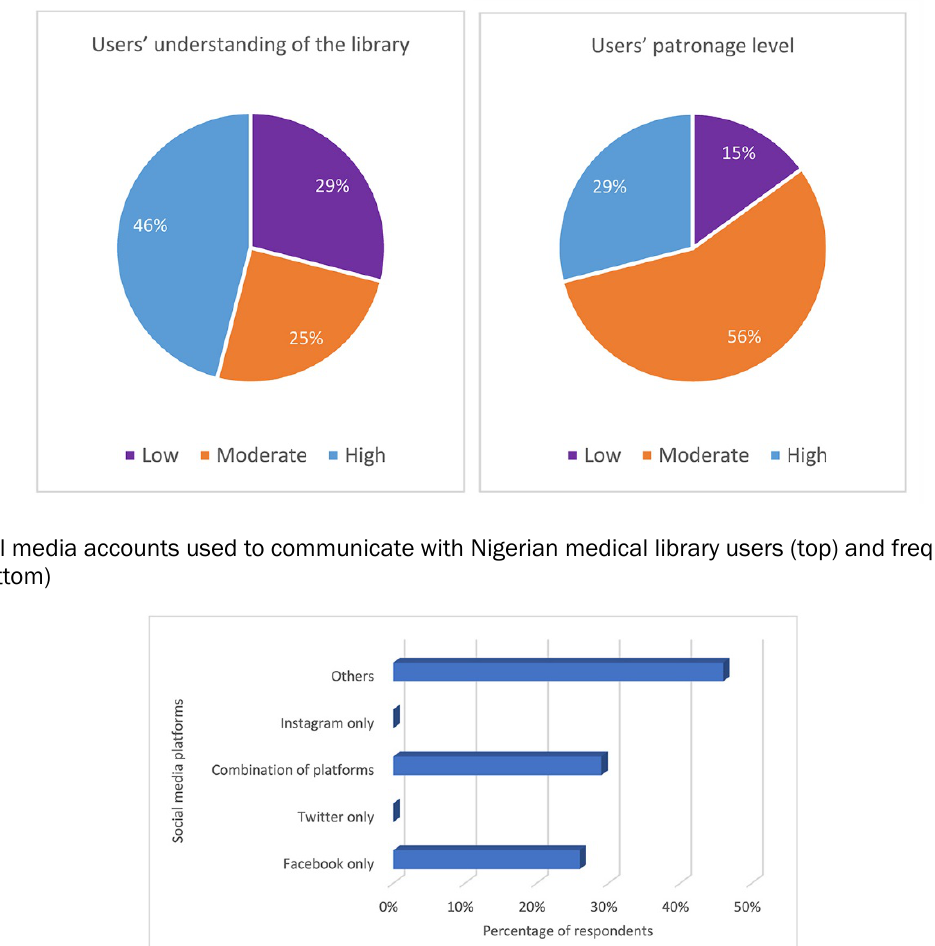
Figure 1 Librarians’ perceptions of users’ understanding and usage of Nigerian medical libraries